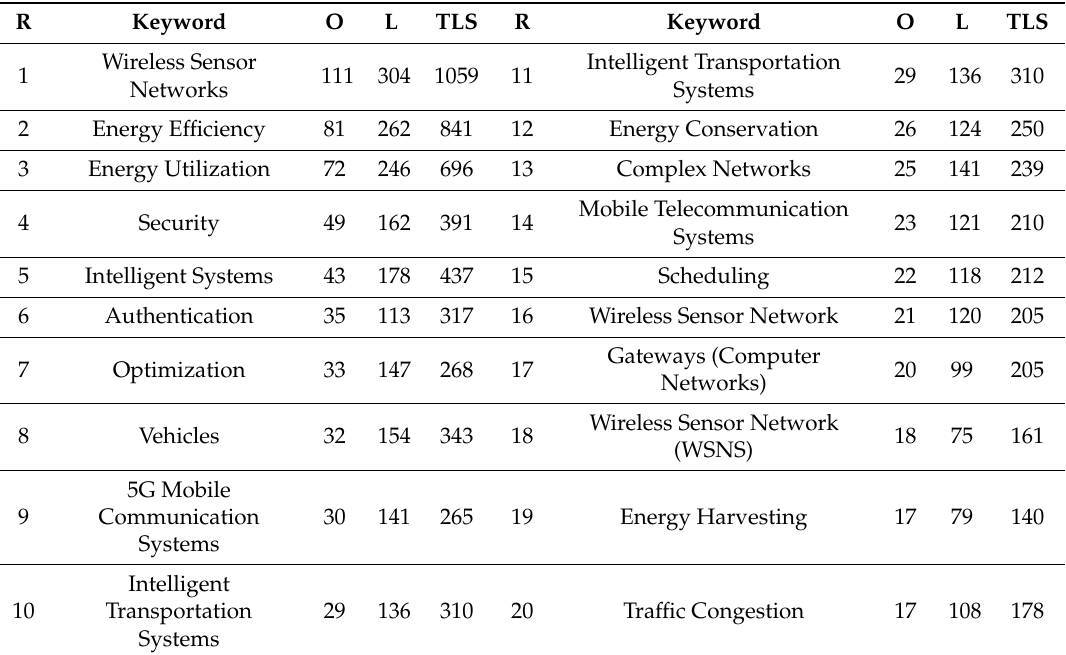
Table 5. Cluster 2: Top 20 keywords (2011–2019).